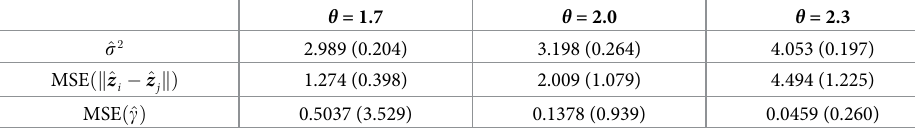
Table 2. Parameter estimates for the no covariate